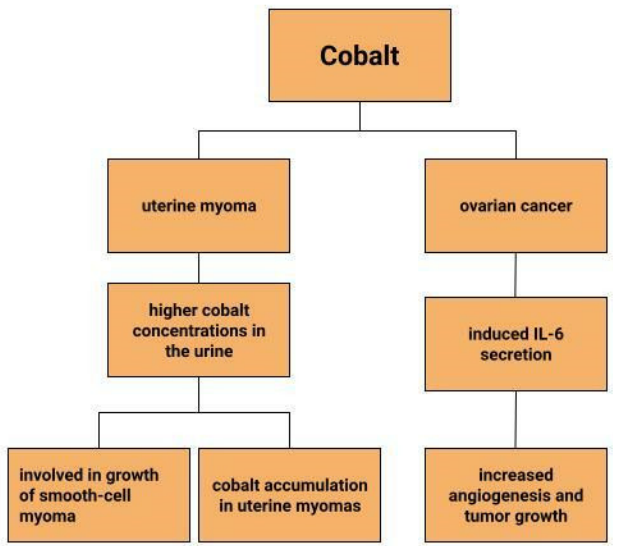
Figure 4. The role of cobalt in gynecological diseases.